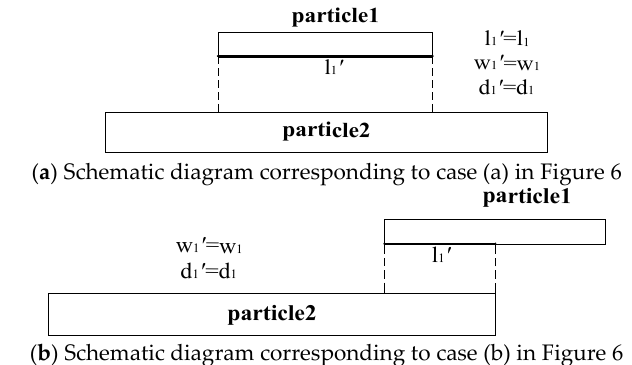
Figure 9. Schematic diagram of the projection step as plate2 is treated as the wall.